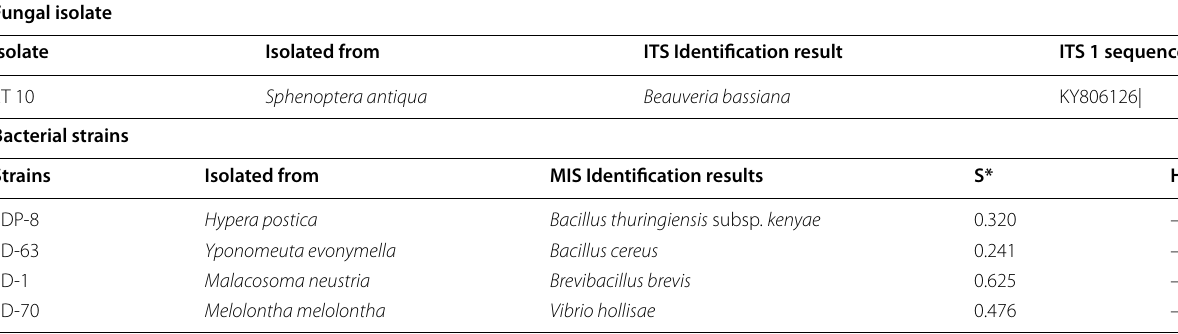
Table 1 Bacterial strains and fungal isolate used in the study Fungal isolate Isolate Isolated from ITS Identification result ET 10 Bacterial strains Strains S: similarity; : negative effect; HR: hypersensitivity −